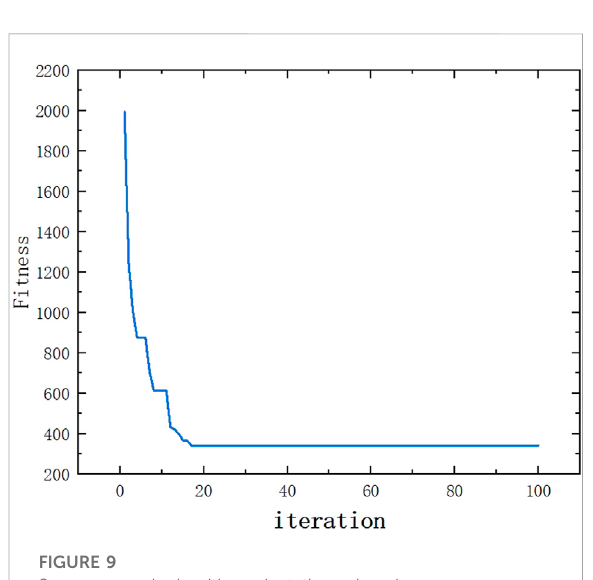
FIGURE 9 Sparrow search algorithm adaptation value